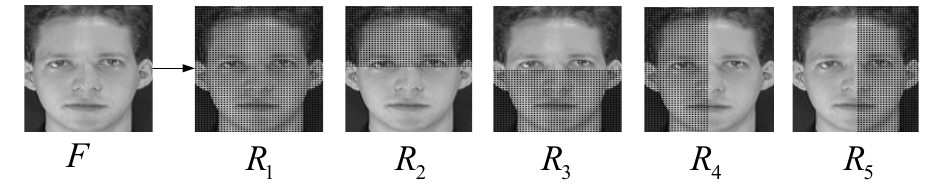
Figure 1. Five regions of a face image. Five WRCMs are constructed from the corresponding